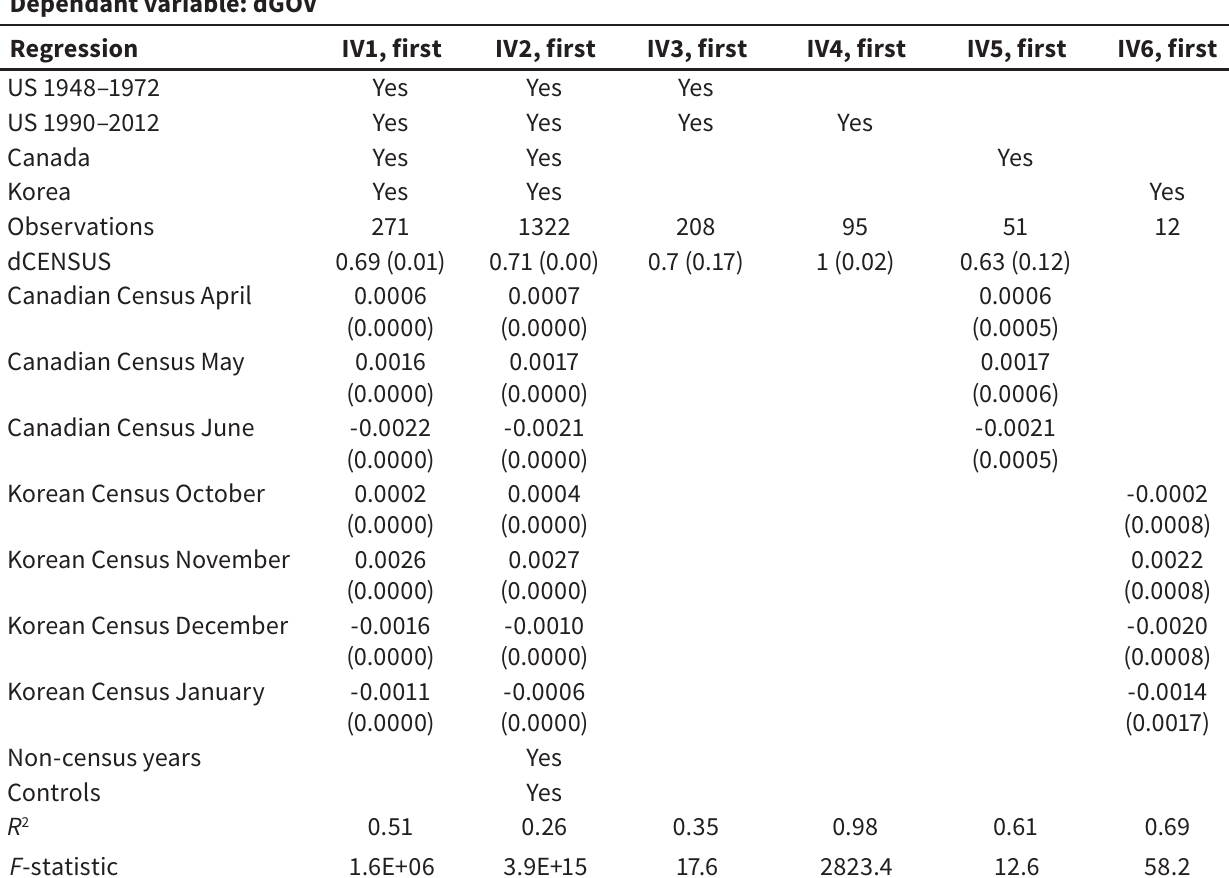
First-stage instrumental